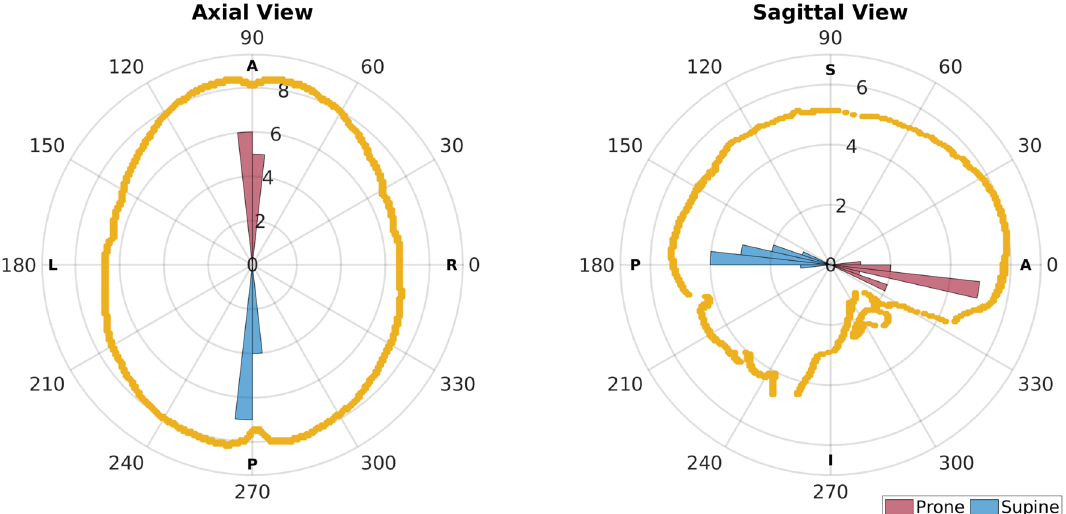
Figure 1. Polar histograms of the direction of gravity (i.e., head orientation of participants) during scanning. On the left, greater values of azimuth angle represent head of the participant turned right during scanning. On the right, higher values of elevation angle represent head of the participant tilted downwards during scanning. The shape of the skull from the MNI atlas is overlapped as reference for the neutral head orientation.